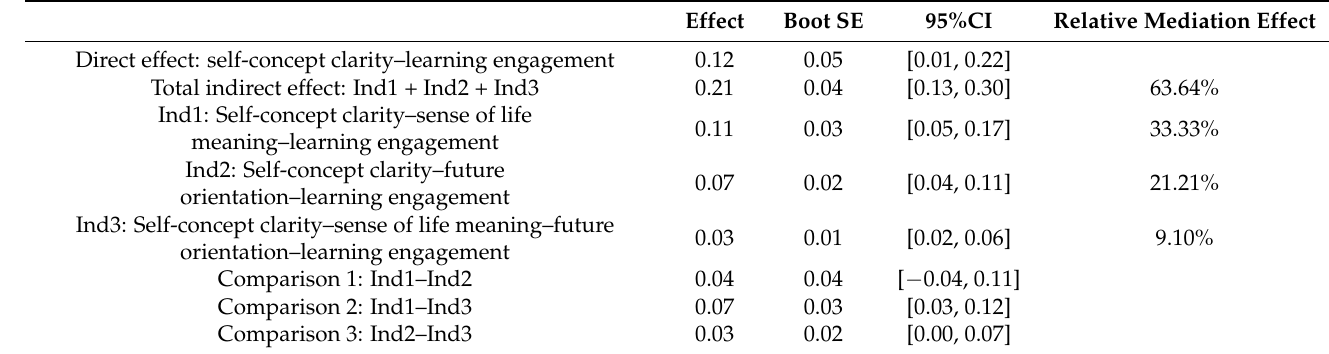
Table 3. Analysis of sequence-mediating effects of sense of life meaning and future orientation. Effect Boot SE 95%CI Relative Mediation Effect